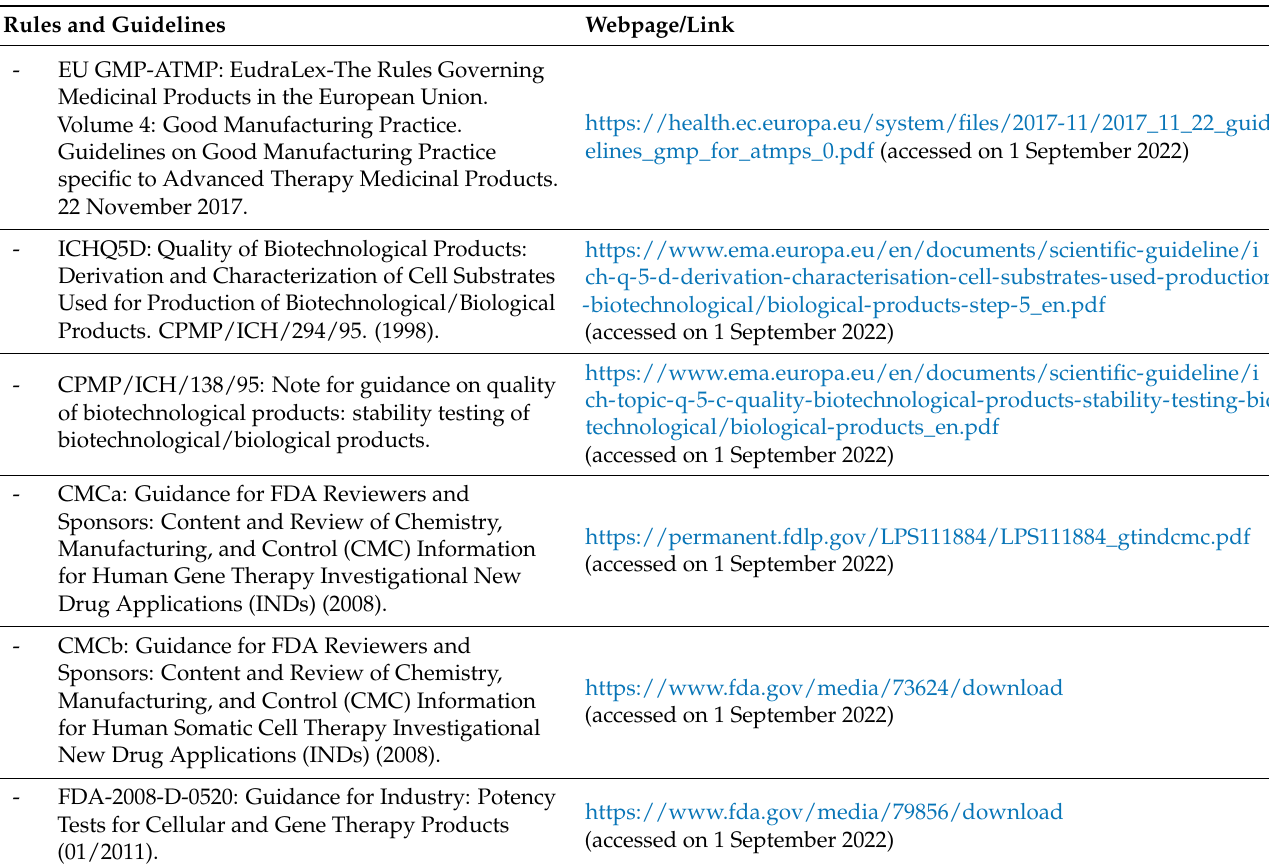
Table 2. Rules and guidelines that regulate advanced therapies medicinal products (including allogeneic